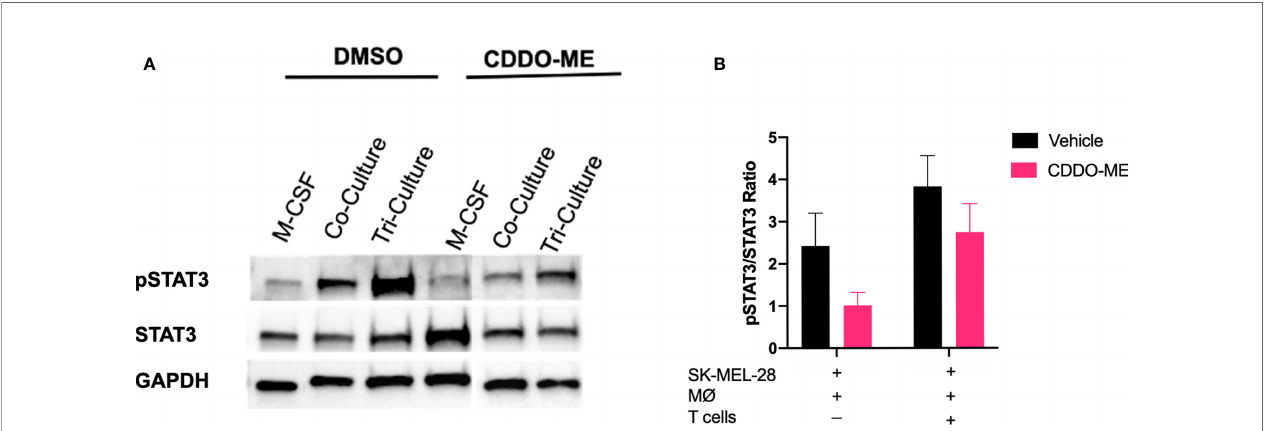
FIGURE 5 | CDDO-Me treatment inhibits STAT3 phosphorylation in melanoma-conditioned macrophages. Whole cell lysates were prepared from human monocytes cultured for 5 days with cytokine in the absence (M-CSF) or presence of SK-MEL-28 cells (co-culture) or SK-MEL-28 cells and T cells (tri-culture). Cultures were treated with or without CDDO-Me (300 nM) for 16 h, washed, and then activated with LPS (10 ng/ml) for an additional 24 hrs. (A) Total and pSTAT3 levels were measured by immunoblot; GAPDH served as loading control. (B) Quanti fi cation of band intensity (ratio of pSTAT3/STAT3). Total STAT3 and pSTAT3 proteins were fi rst normalized to their respective GAPDH signals. The ratio of GAPDH-normalized pSTAT3 to GAPDH-normalized total STAT3 was plotted for each treatment condition. vs. untreated control (two-way unpaired t test). Data are representative of results obtained from analysis of 3 individual donors and 3 separate experiments for each donor. Error bars represent standard deviation